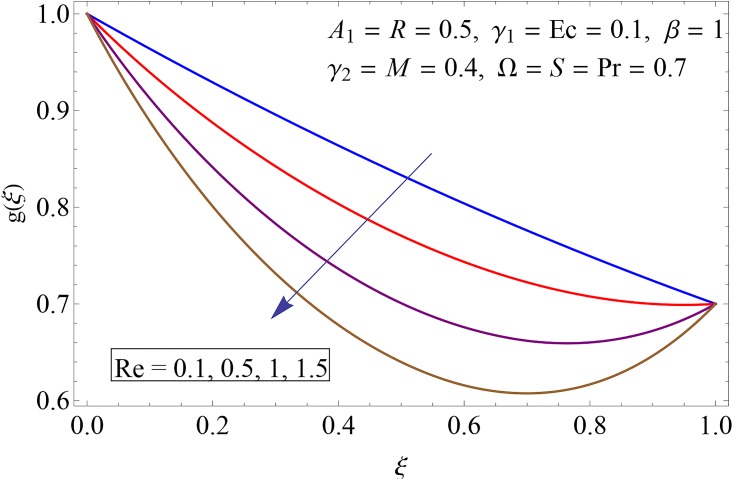
Impact of Re on g(ξ).